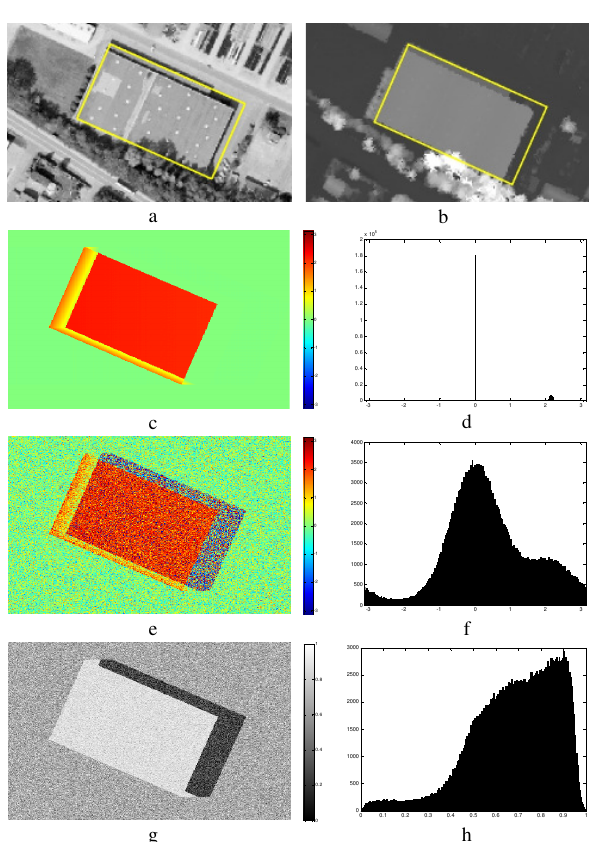
Figure 2. Simulated building signature: a) optical and b) LIDAR image overlaid with GIS information, c) simulated phases and d) histogram, e) noisy simulated phases and f) histogram, g) noisy simulated coherence and h) histogram